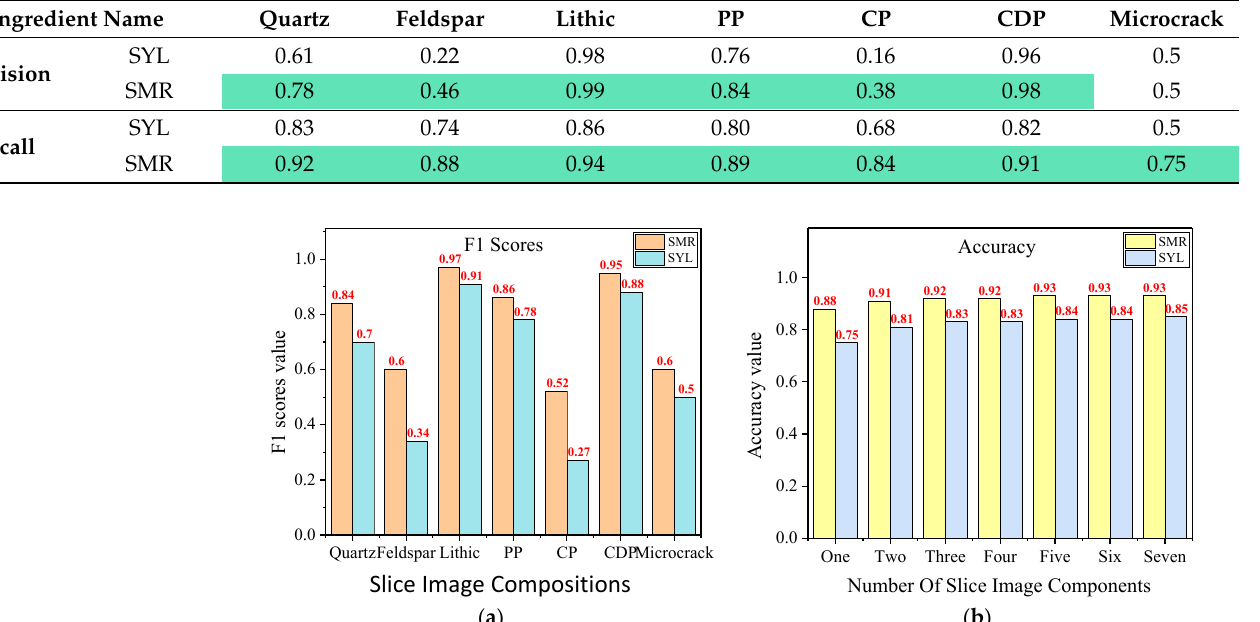
Table 3. MRT values for different data sets.